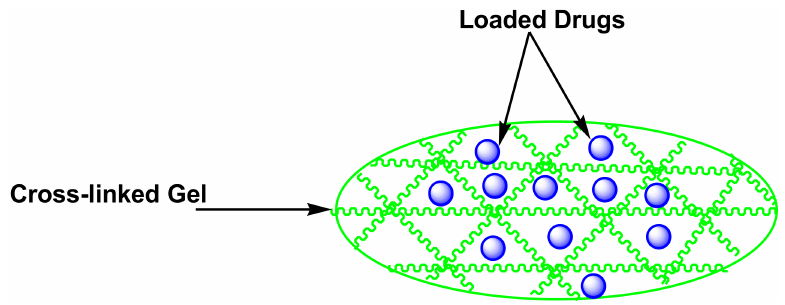
Figure 8. A schematic diagram of thermosensitive gel loaded with